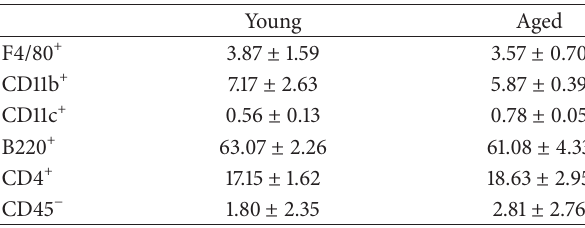
Table 1: The expression of surface markers on splenocytes of young and aged